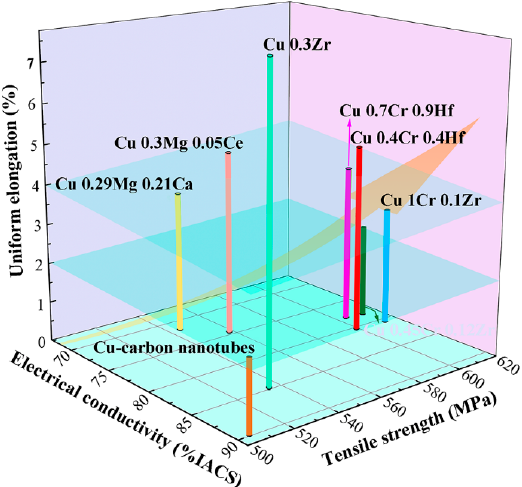
Figure 7. Combinations of ultimate tensile strength, uniform elongation and electrical conductivity in comparison with those of the previously reported copper